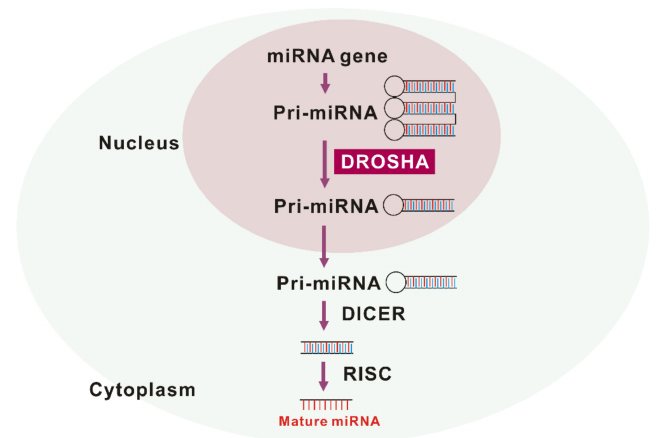
Figure 1. The maturation of miRNA by drosha ribonuclease III